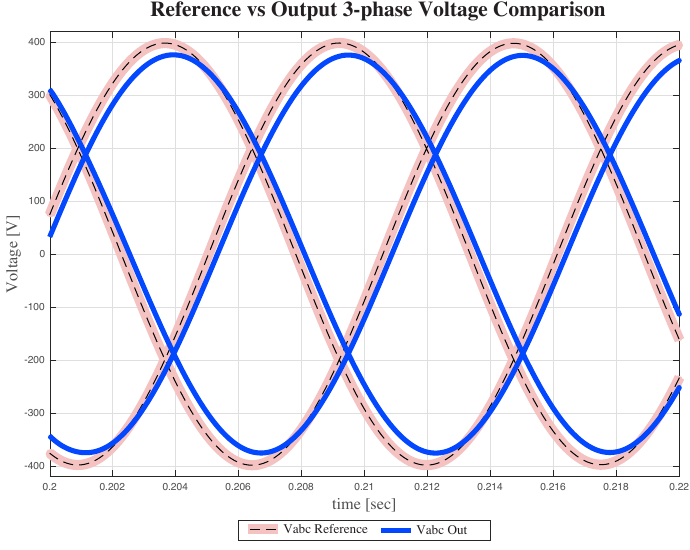
Figure 6. Comparing the reference voltage with the voltage output